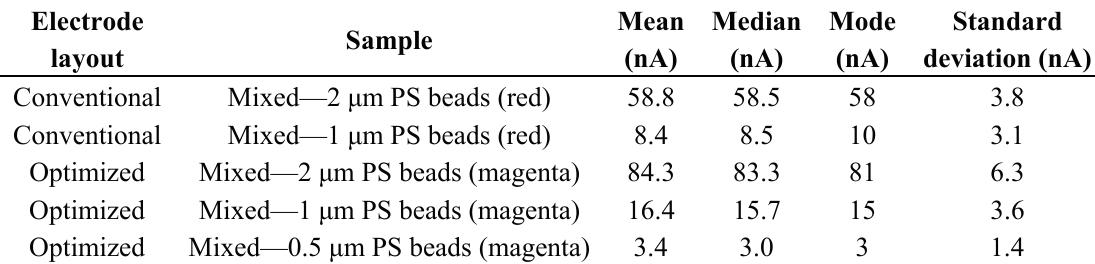
Figure 6. Histogram of the maximum current response of samples with beads with a diameter of 2 μ m for the optimized (blue) and conventional (green) chip designs and samples with mixed beads with diameters of 0.5, 1, and 2 μ m for the optimized (magenta) and conventional (red). Table 1. Calculated mean, median, mode and standard deviation of the two populations obtained from the measurements of the mixed sample in the conventional chip (red) and the three populations obtained from the measurements of the mixed sample in the optimized chip (magenta) shown in Figure